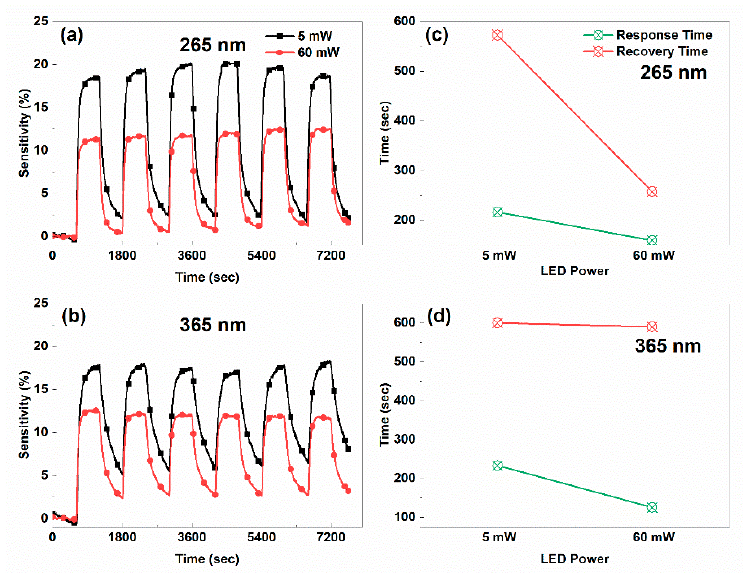
Figure 7. Short-term repeatability response at fixed 20% RH of 1 ppm NO 2 for Au/In 2 O 3 sensors under ( a ) 265 nm and ( b ) 365 nm with 5 mW and 60 mW LED power. Response time and recovery time improve as LED power increases under 265 nm ( c ) and 365 nm ( d ).